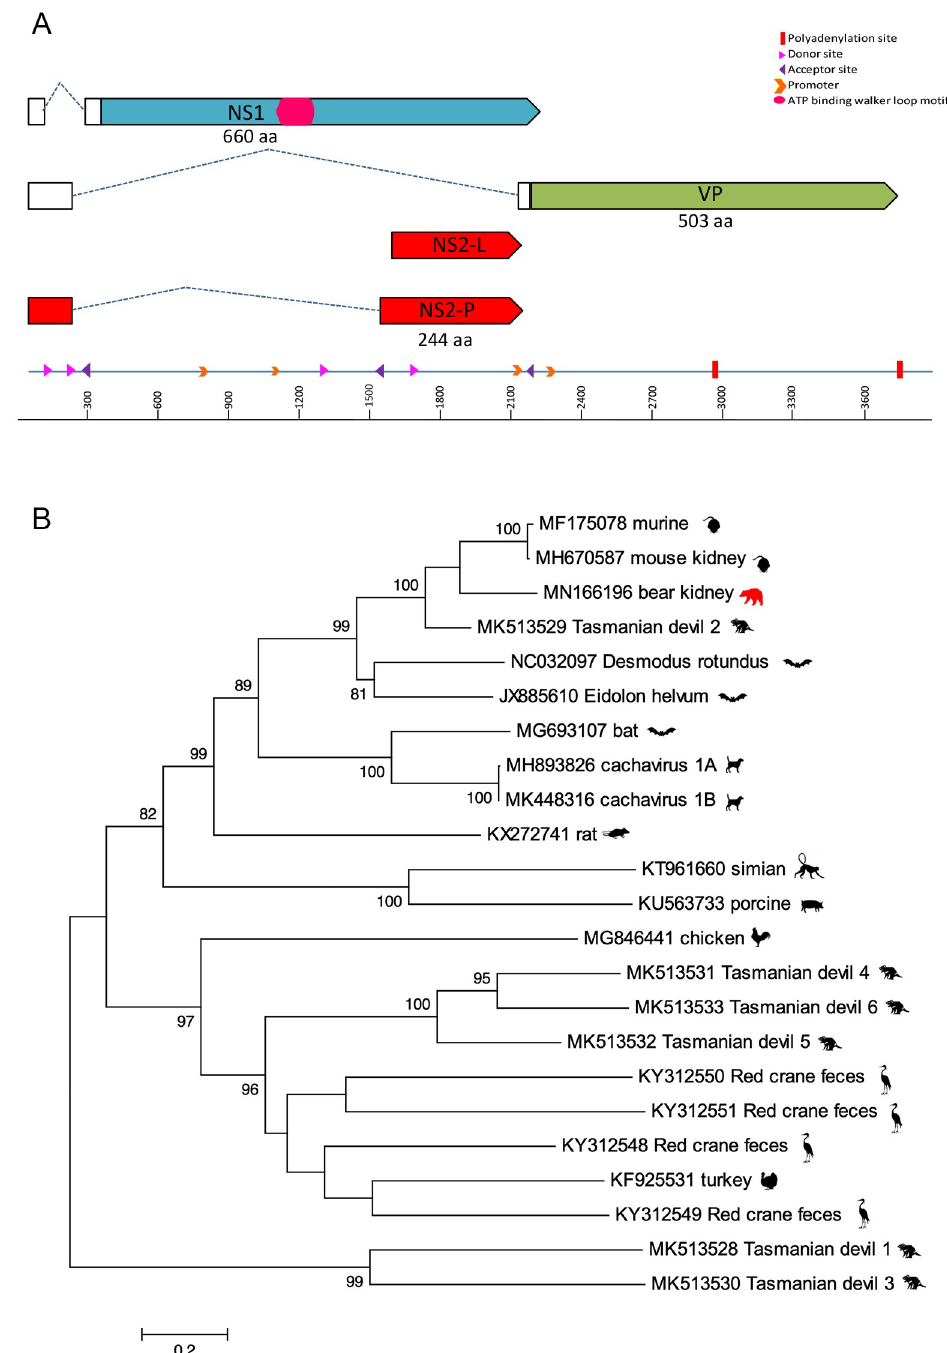
Fig 1. A. The genome schematic of UaPV. Clear boxes represent untranslated regions, while the dashed lines represent splicing. The arrows represent ORFs. B. Maximum likelihood tree of NS1 aa chaphamaparvovirus sequences. Bar, 0.2 amino acid substitutions per site. Bootstrap values below 60 were